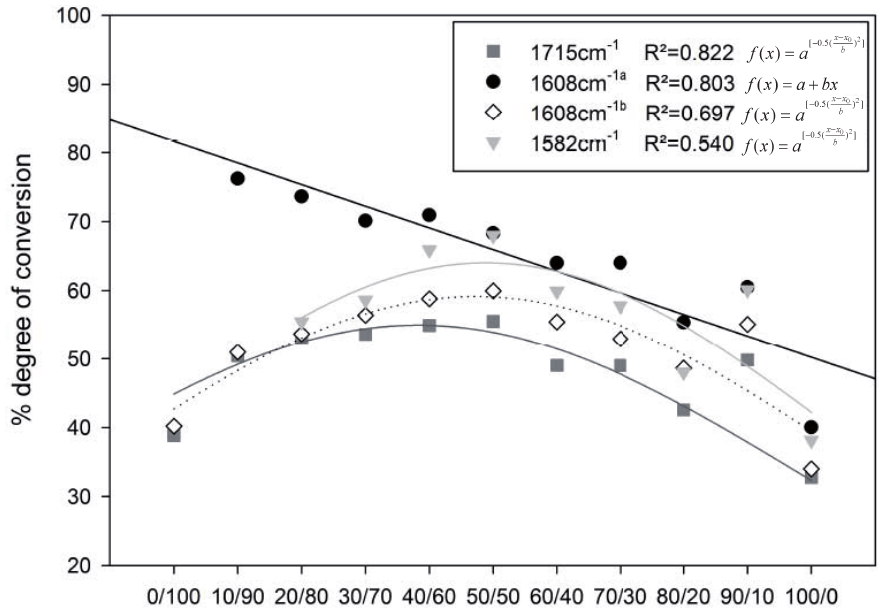
Figure 3 - Regression